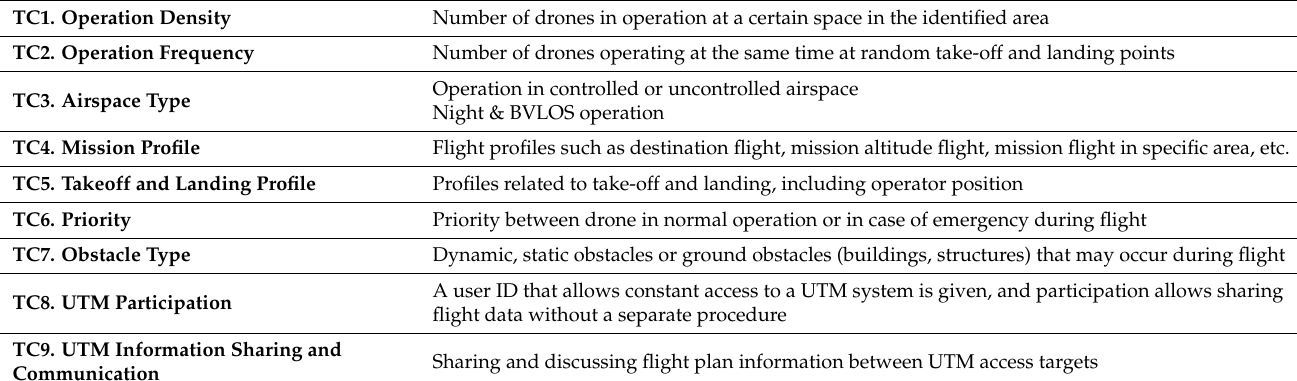
Table 2. Test Components